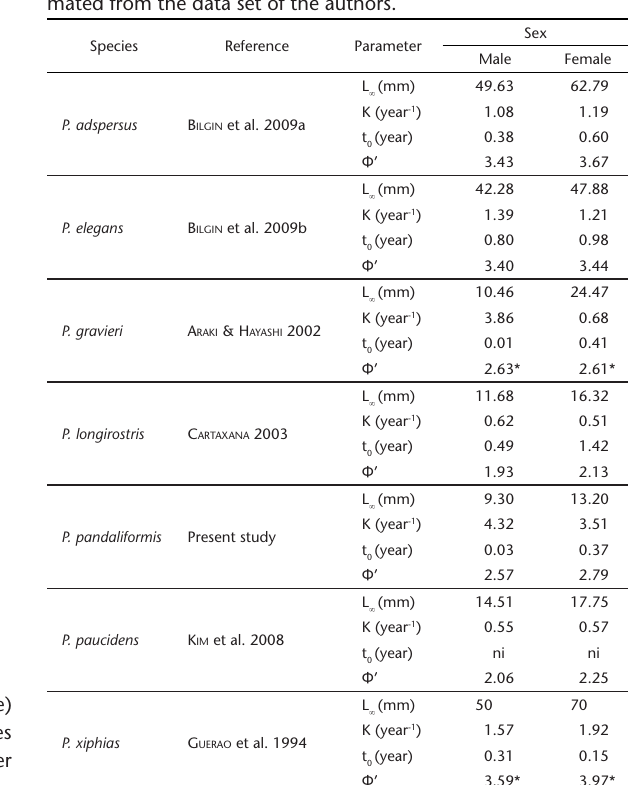
Table 1. Von Bertalanffy growth parameters estimated from the length frequency distribution analysis for males and females of Pa- laemon pandaliformis and a comparison between studies involving shrimps in the Palaemon genus. (L ) asymptotic carapace length ∞ (mm), (K) growth coefficient (year -1 ), (t ) age at zero length, ( Φ ’) 0 growth performance index, (ni) data not informed, (*) values esti- mated from the data set of the